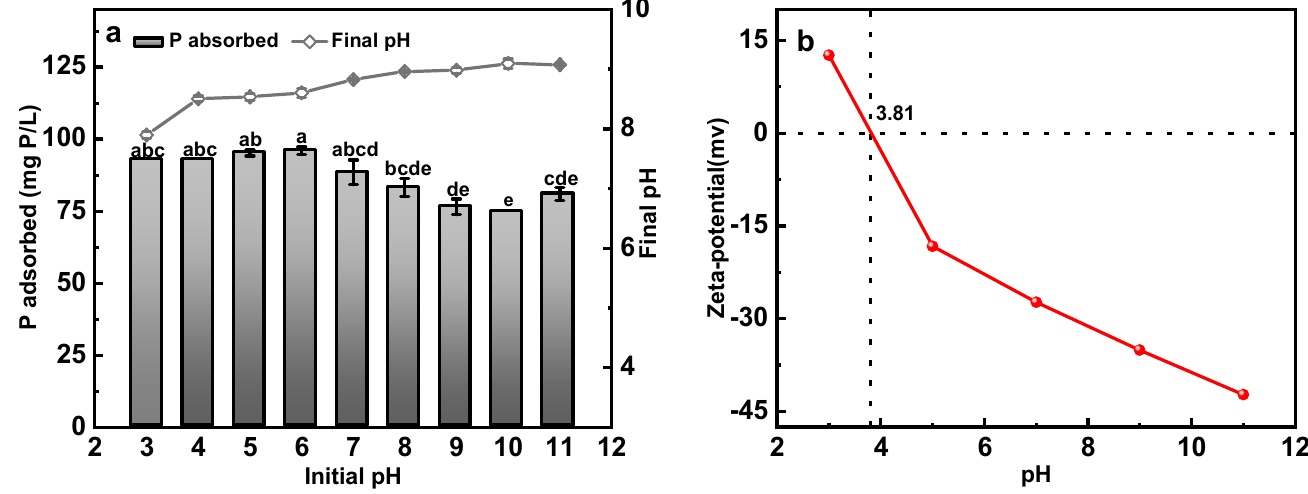
Figure 2. The effect of initial pH on phosphate adsorption on Ca-BC ( a ) (Dosage: 0.05 g; Temperature: 25 °C; Time: 24 h; Initial phosphorus concentration: 150 mg P/L). Zeta potentials of Ca-BC ( b ). The letters a, b, c, d, e represent the results of significance analysis of variance.